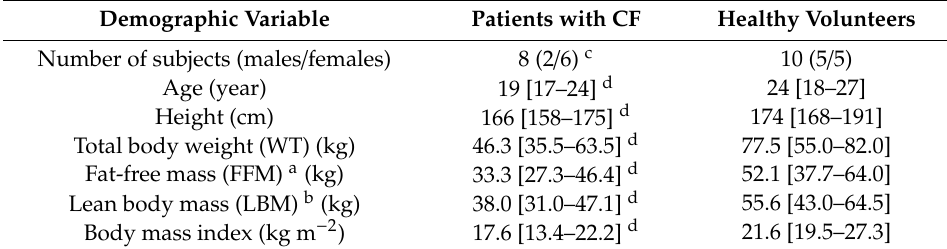
Table 1. Demographic data (median [range]) of patients with CF and healthy volunteers.